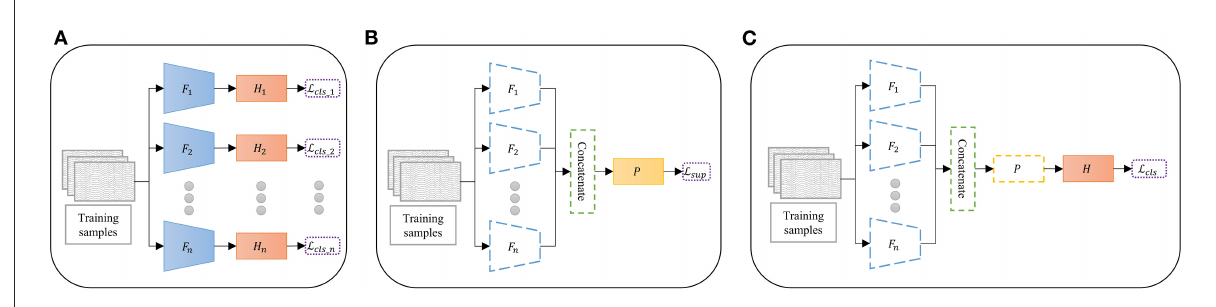
FIGURE1 Overview of the proposed multibranch convolutional neural network with contrastive representation learning via sequential optimization. (A) Pretraining: The base learners are separately pretrained on the same dataset. (B) Contrastive representation learning: The features of the pre-trained extractors are concatenated and optimized. (C) Fine-tuning: The classifier is trained on the projected feature. Dashed lines indicate the frozen model, F is the feature extractor, H is the classifier, P is the feature projector, L cls is the cross entropy loss function, and L sup is the supervised contrastive loss